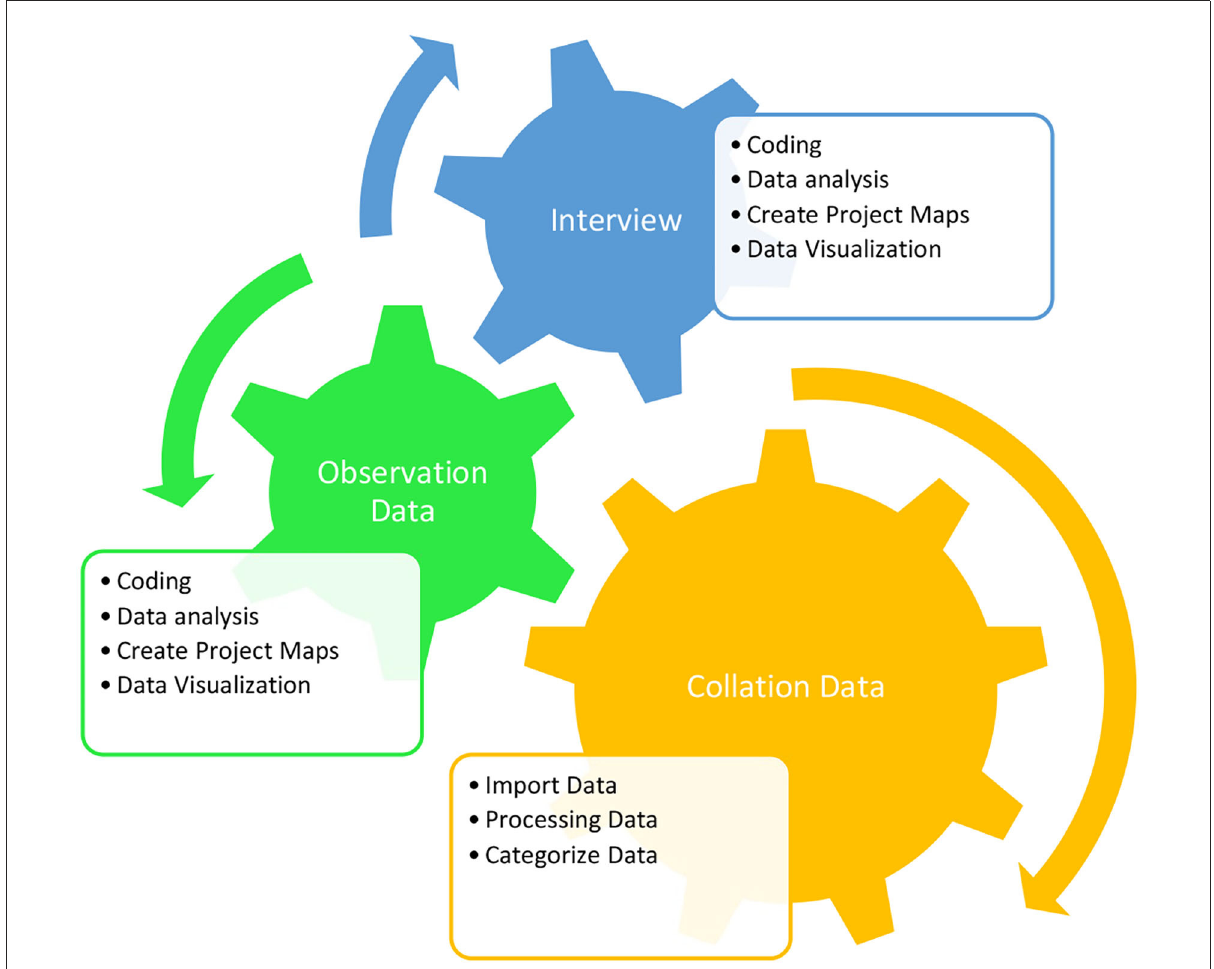
FIGURE2 Data collection and analysis techniques with NVivo 12 Pro. Source: Processed from Woolf and Silver (2017),